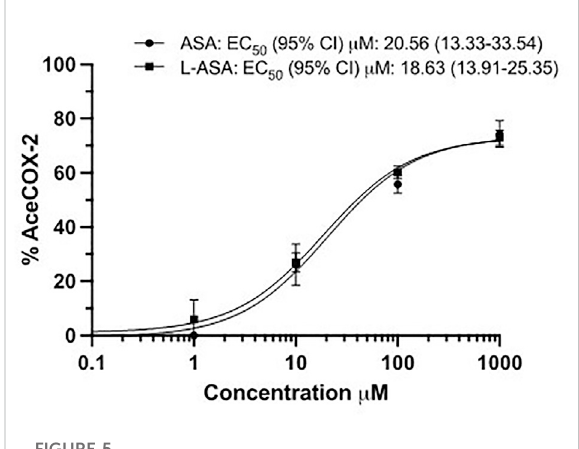
FIGURE 5 The extent of COX-2 acetylation at Serine516 in HCA-7 cells by ASA and L-ASA. HCA-7 cells (3.0 × 10 6 ) were treated with DMSO, the diluent or increasing concentrations of ASA or L-ASA for 60 min at 37 ° C. The cells were lysed, and the quanti fi cation of acetylated and unacetylated COX-2 was performed after protein digestion by LC-MS/MS as described in Materials and Methods. The percentage of COX-2 acetylation to total COX-2 was calculated (%AceCOX-2). Results are shown as mean ± SD, n = 3 – 4. Concentration-response curves were fi tted, and IC 50 or EC 50 values with 95% Con fi dence Interval (CI) values are